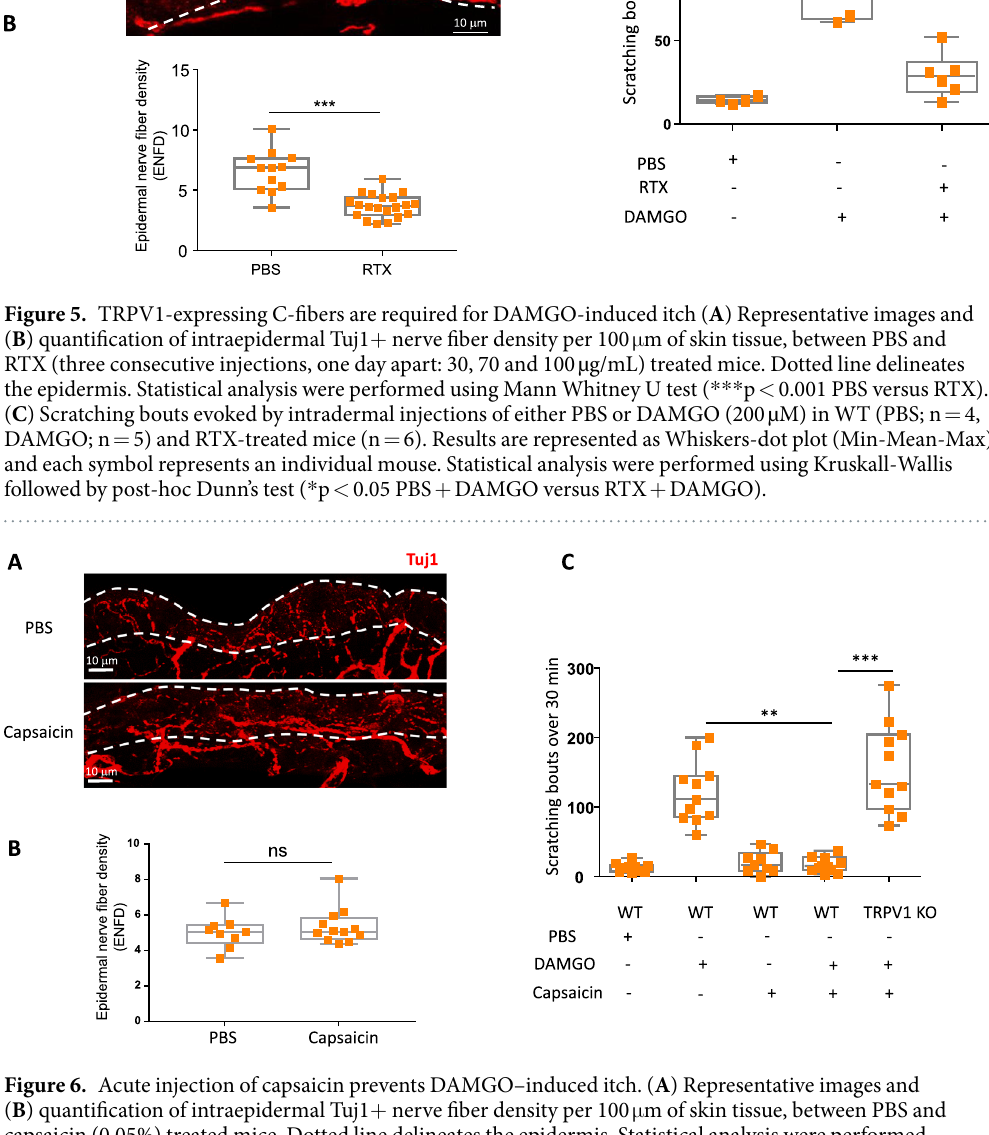
What singles out our findings from the data of others is that, although eliminating the TPRV1 sensory fibers abolishes MOR-induced itch, the presence of the fibers devoid of TRPV1 in the TRPV1-null mice still enables MOR signalling and does not affect itch response. It is well established that TRPV1 is expressed in a large subset of itch-sensing neurons that are activated by a variety of pruritogens 24 . However, TRPV1 does not transduce itch for